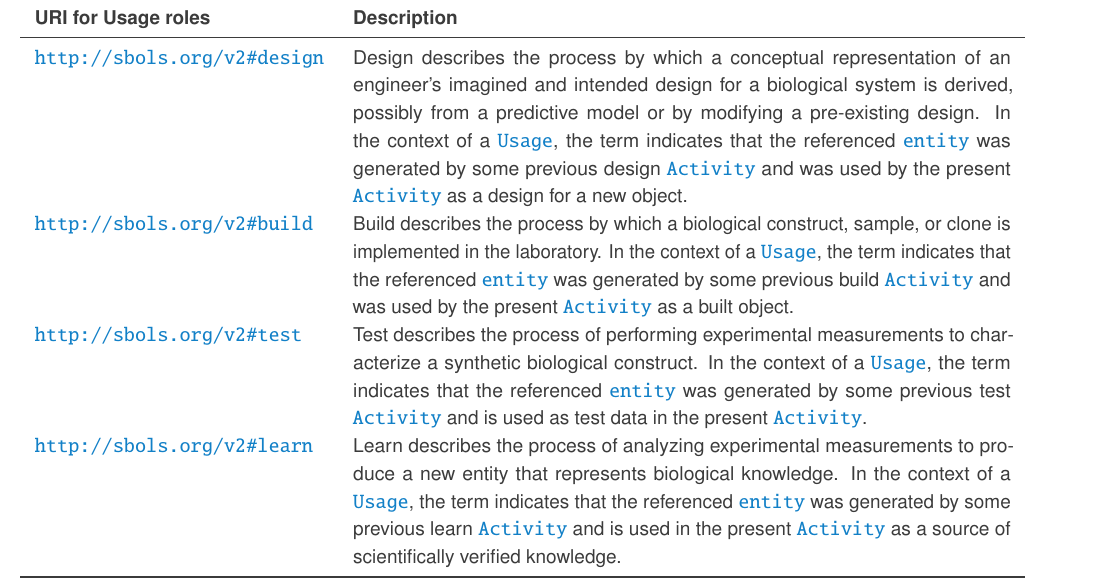
Table 19: Terms to specify the roles property of a Usage